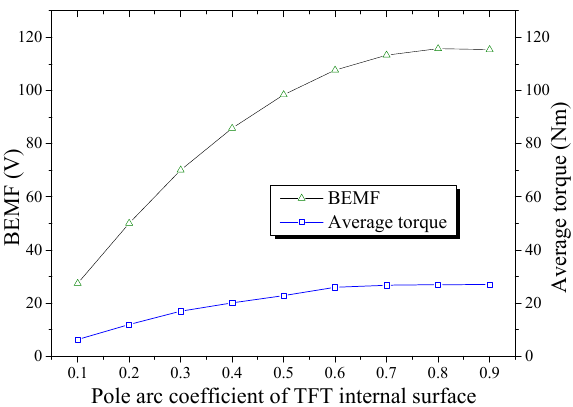
Figure 17. Variation of BEMF and average torque versus pole arc coefficient of the TFT internal surface.